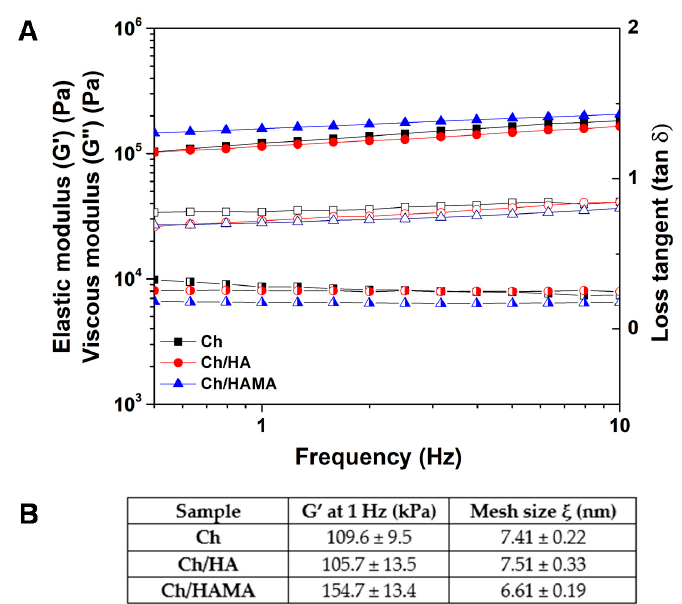
Figure 3. Evolution of elastic (G’, filled) and viscous (G”, unfilled) moduli, and loss tangent (tan δ , half-filled) as a function of applied frequency at constant strain of 0.1% of Ch, Ch / HA, and Ch / HAMA polymeric membranes ( A ). The average mesh size values ξ of Ch, Ch / HA and Ch / HAMA polymeric membranes determined at a frequency of 1 Hz ( B ).